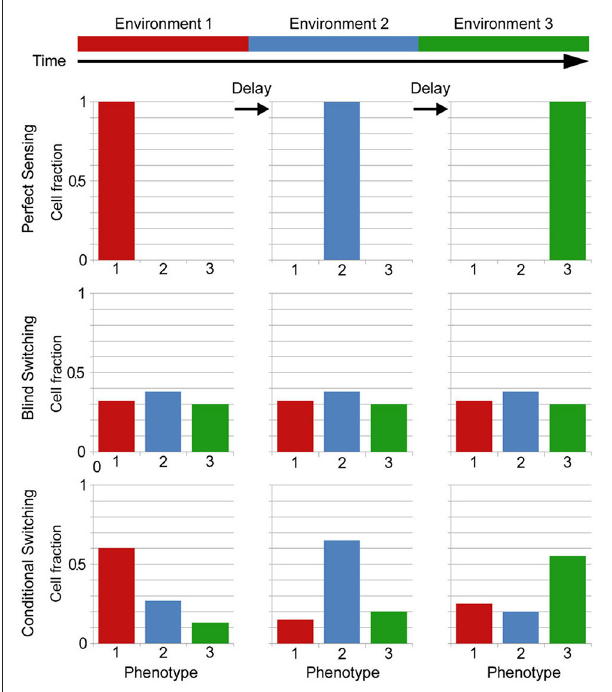
FIGURE 1 | Sketch of phenotype distributions corresponding to different strategies for adapting to fluctuating environments. In this example there are three possible environmental and corresponding phenotypic states. In perfect sensing, cells measure the environment and all change to the correct state. In blind stochastic switching, cells just try to maintain a distribution (which doesn’t have to be uniform) regardless of environment. Here we don’t show the important effect that growth differences would have, biasing the distribution to the correct state. In conditional stochastic switching, cells switch between states but with rates that depend on information from the environment and can bias it to the correct one even discounting growth